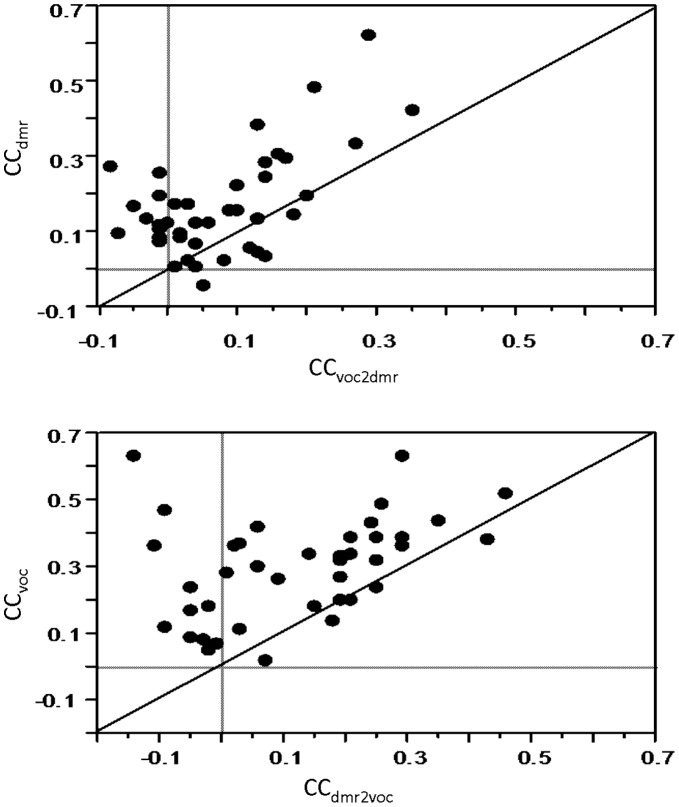
Across stimuli STRF predictions.Top: Scattergram showing the CC values when STRFdmr are used to predict responses to DMR (CCdmr, ordinates) against CC values when STRFvoc is used to predict responses to DMR (CCvoc2dmr, abscissa). Bottom: Scattergram showing the CC values when STRFvoc are used to predict responses to vocalizations (CCvoc, ordinates) against CC values when STRFdmr is used to predict responses to vocalizations (CCdmr2voc, abscissa). In both cases, the large majority of values are higher when the same stimulus set is used for computing the STRF and for predicting the response (dots are mainly above the diagonal line).